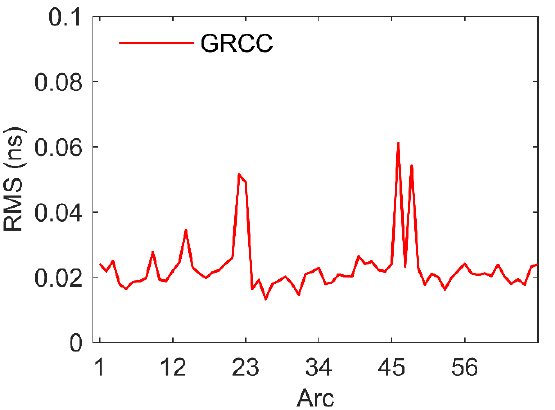
Figure 6. The difference in GRCC’s clock offset between solutions using nominal and measured